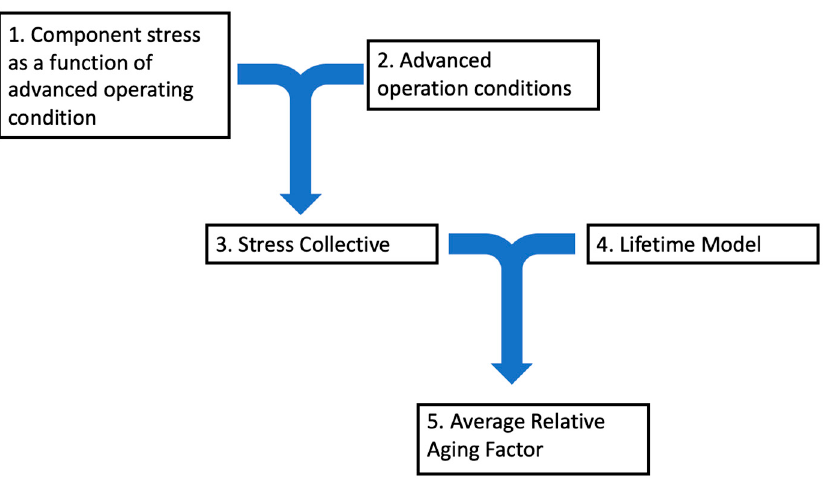
Figure 1. Framework for evaluating PV inverter reduction in useful life based on advanced inverter operation.